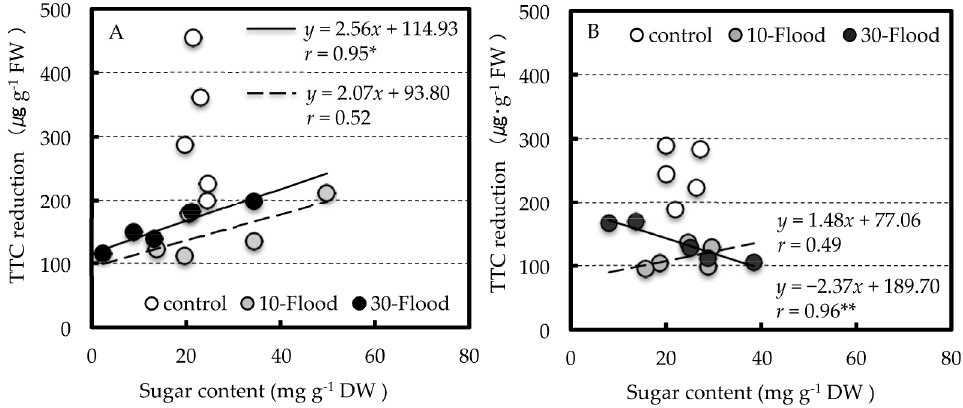
Figure 5. Effects of treatment on relationships between TTC reduction and sugar content in the roots of grafted trees ( A ) and seedlings ( B ) of mango. Both grafted trees and seedlings show the results measured on 31 July. As a result of the regression analysis, a significant result was obtained only in 30-flood. * and ** indicate significance at p = 0.05, p = 0.01,